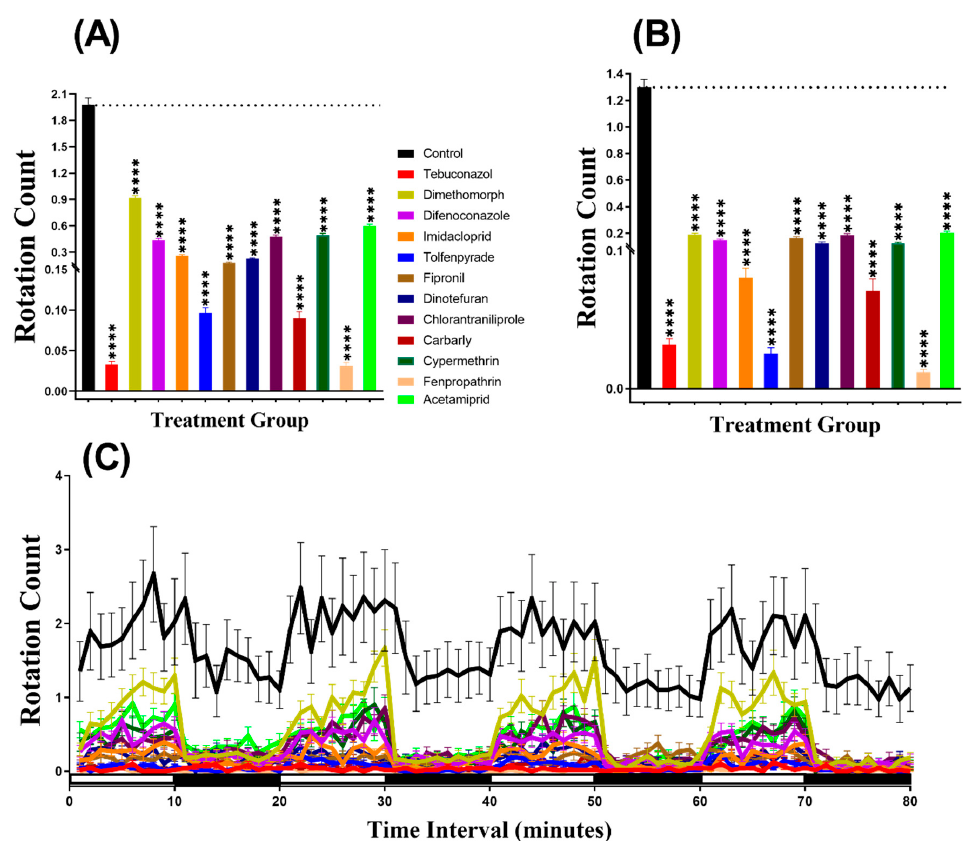
Figure 7. Total rotation count of control and Daphnia magna after 24-h exposure to 1 ppb pesticides. ( A ) Rotation counts during the light cycle. ( B ) Rotation count during the dark cycle. ( C ) The pattern of rotation counts in light and dark transition. The data are expressed as the Mean ± SEM and they were analyzed by Two-way ANOVA and Brown–Forsythe test. Dunnett’s multiple comparison test for comparing all treatments with control was carried out to observe the effect of the pesticides ( n = 48; **** p < 0.0001).